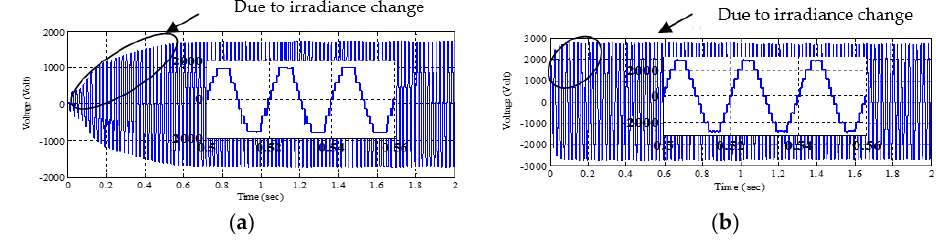
Figure 13. Overall output voltage of 9-level CHB-MLI without filter for ( a ) PV based boost converter obtained by P&O MPPT method ( b ) PV based boost converter obtained by FLC MPPT